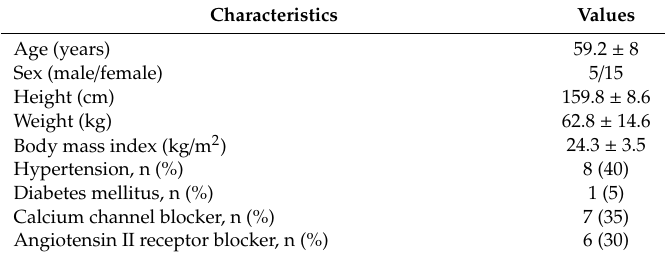
Table 1. Demographics of patients undergoing contrast-enhanced computed tomography ( n =